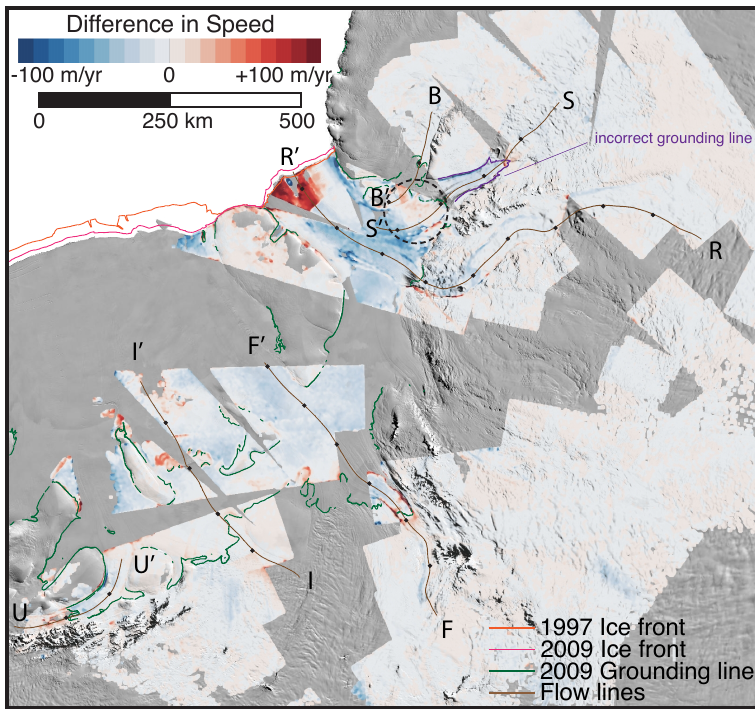
Fig. 4. Map of the difference in speed (2009–1997) detail, 1997 and 2009 ice front, and flow line plots for Filchner-Ronne Ice Shelf overlaid on MOA. Each flow line contains markers every 100km. Corresponding flow line plots are shown in Fig. 5. The purple line is an incorrect grounding line leading to potential residual tide correction errors (marked by a black dashed circle). The dark red region on the edge of the Filchner Ice Shelf indicates a pre-calving